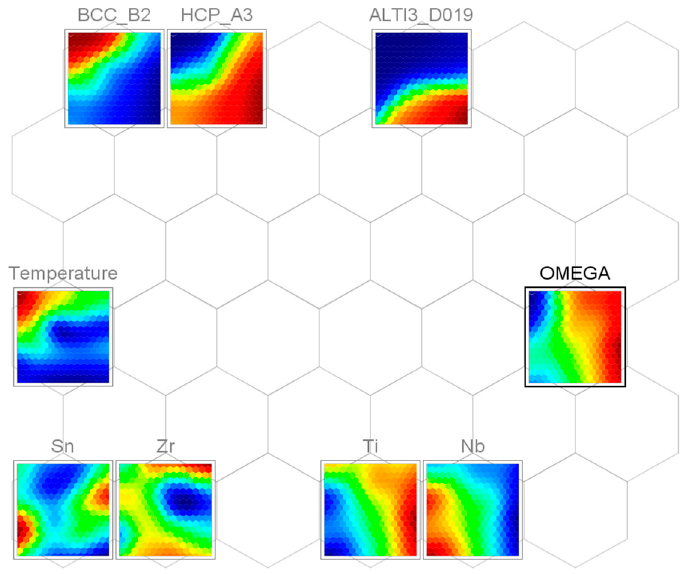
Figure 2. SOM components plot for the Ti-Nb-Zr-Sn system.